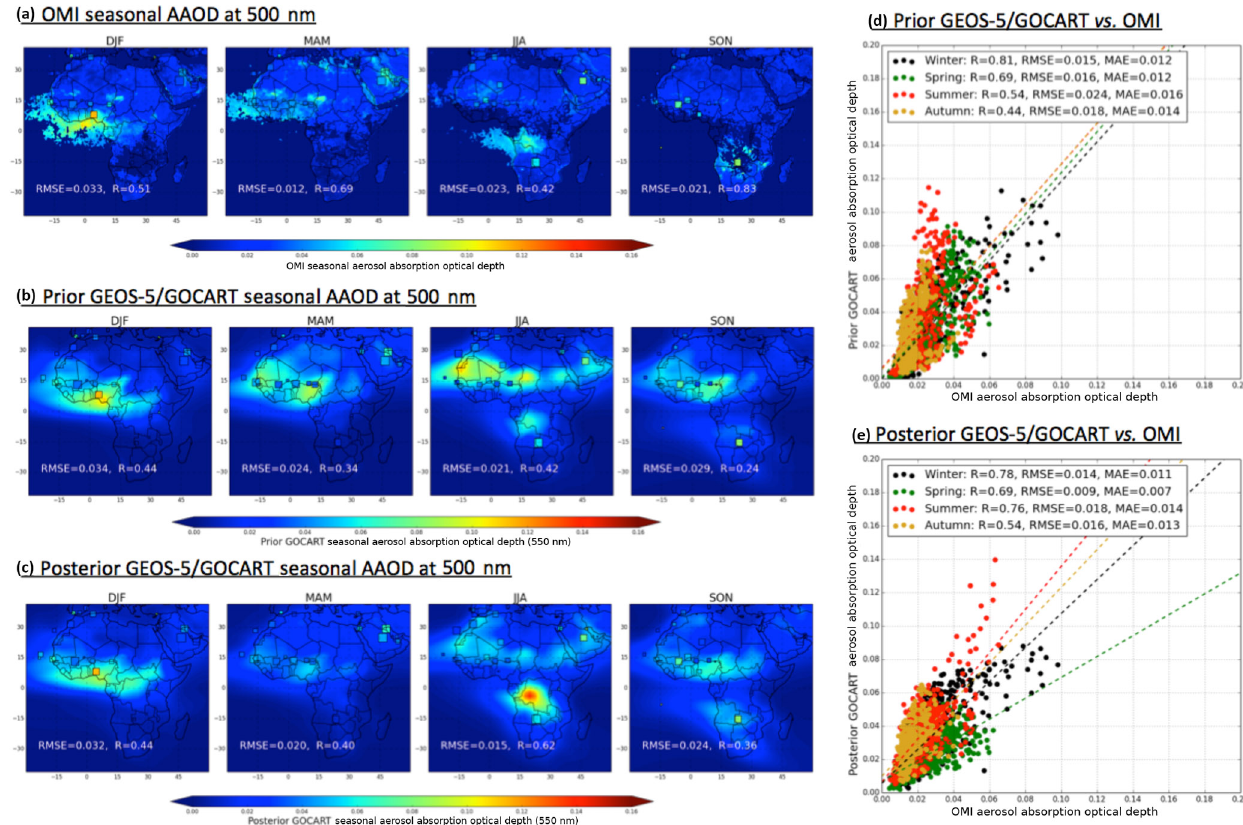
Figure 21. Comparison of the seasonal spatial distribution of prior (b) and posterior (c) GEOS-5/GOCART-simulated AAOD at 550nm with OMI observations (a) . The scatter plots of grid-to-grid comparison between OMI and prior GEOS-5/GOCART AAOD (d) and posterior GEOS-5/GOCART AAOD (e) are also shown. The ground-based measurements from AERONET (squares) are plotted over panels (a) – (c) . The correlation coefficient ( R ) and root-mean-square error (RMSE) versus AERONET are provided in panels (a) – (c) . Meanwhile, the GEOS-5/GOCART versus OMI R, RMSE and MAE are also provided in panels (d) – (e)